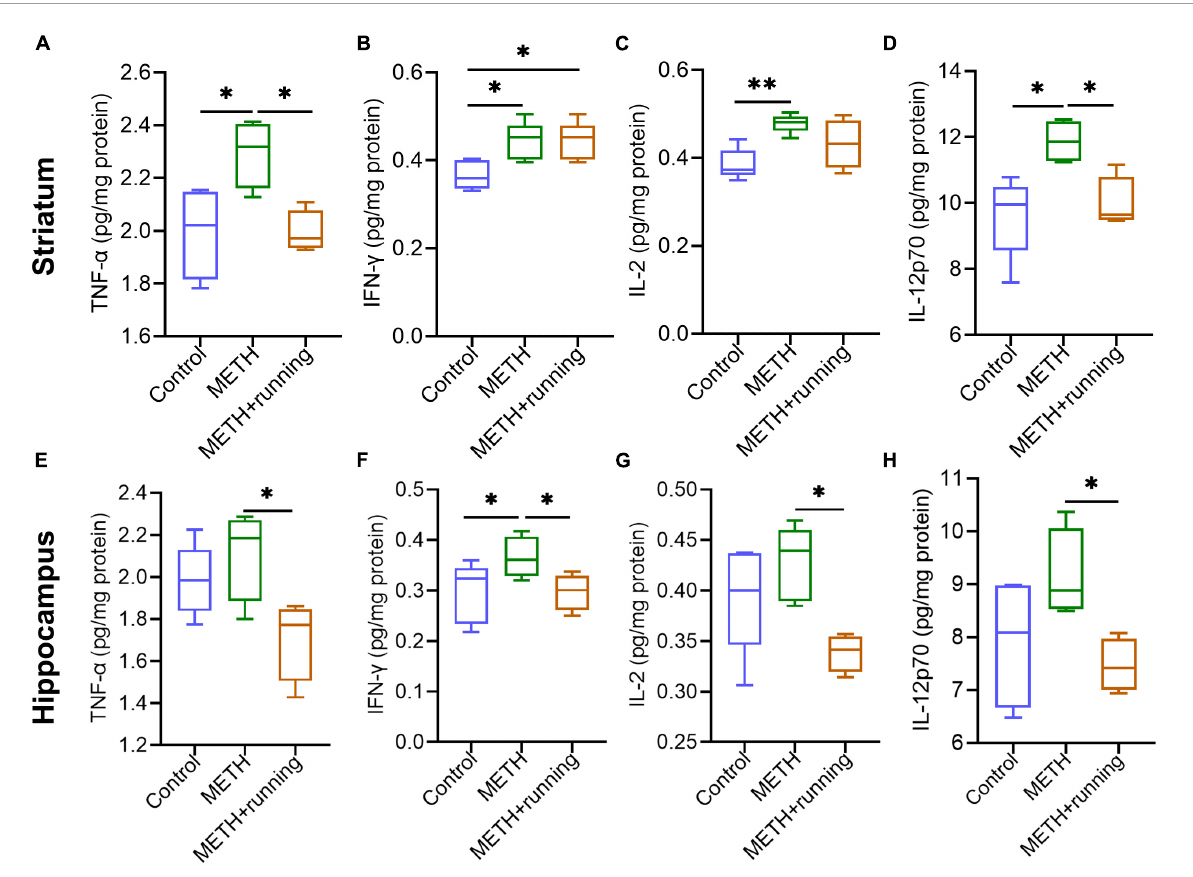
FIGURE6 Treadmill exercise counteracted the increase in proinflammatory cytokine levels in the striatum and hippocampus of METH acute withdrawal mice. (A–H) Treadmill exercise counteracted the increase in proinflammatory cytokine levels in the striatum (A–D) and hippocampus (E–H) of METH acute withdrawal mice. The data are expressed as the mean ± SEM. Significance is shown as * p < 0.05, ** p < 0.01, *** p < 0.001, and **** p <